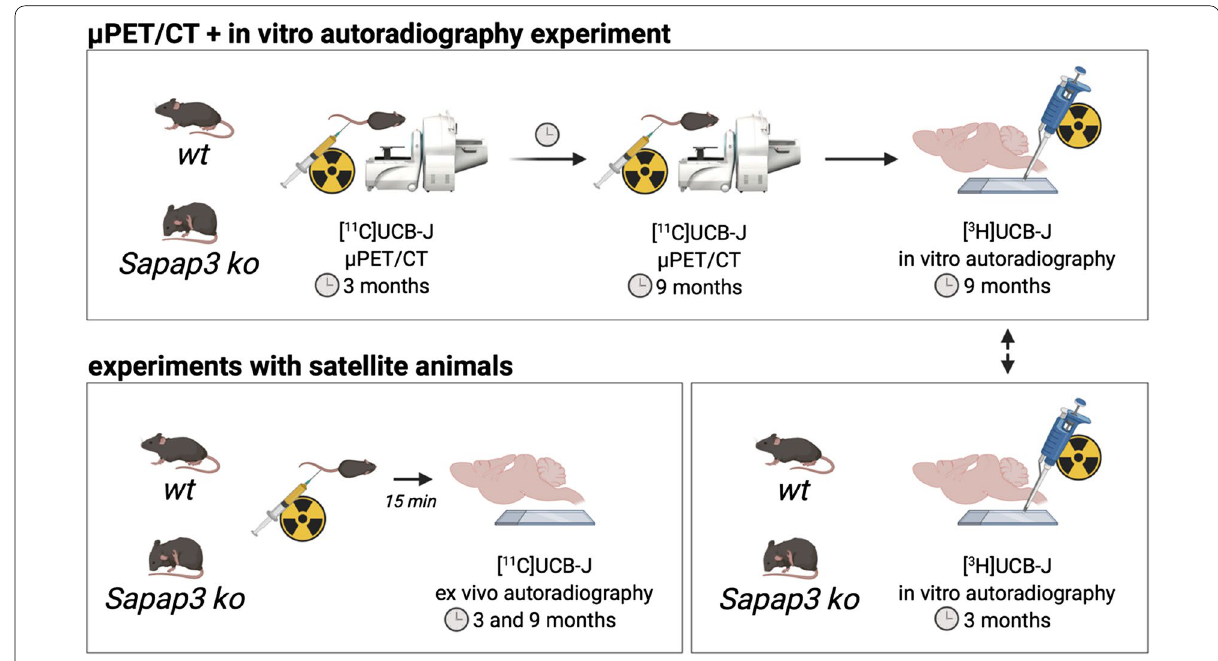
Fig. 1 Overview of all the experimental procedures. (wt